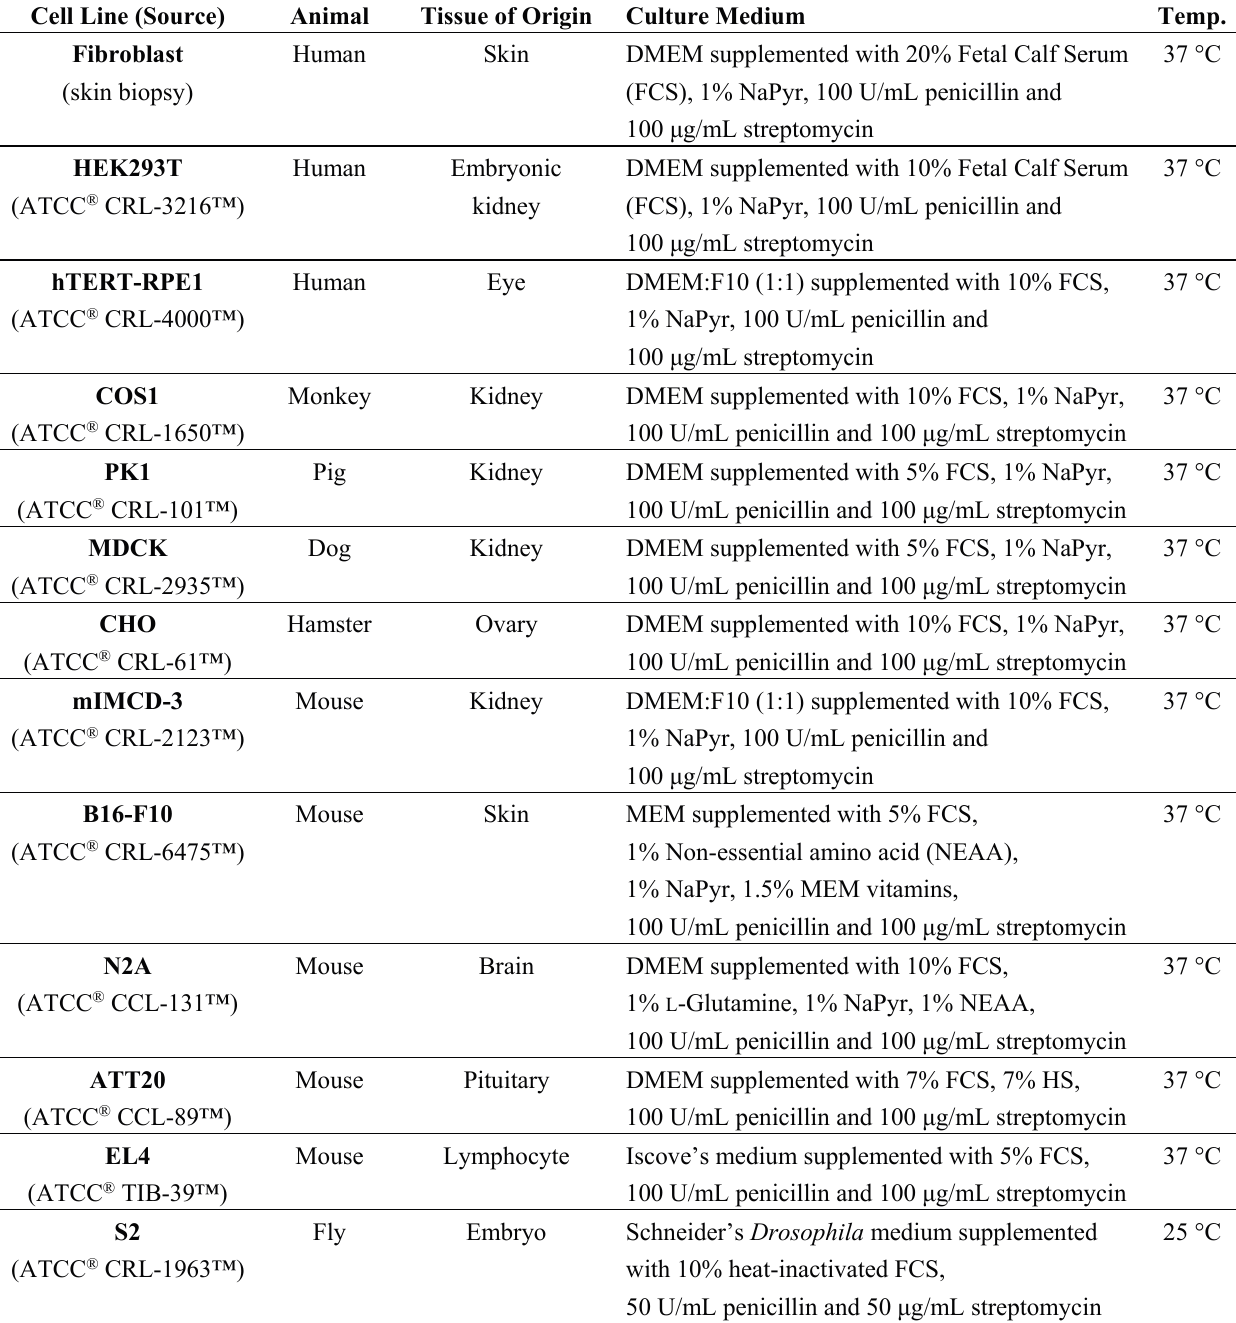
Table 2. Cell lines and growth